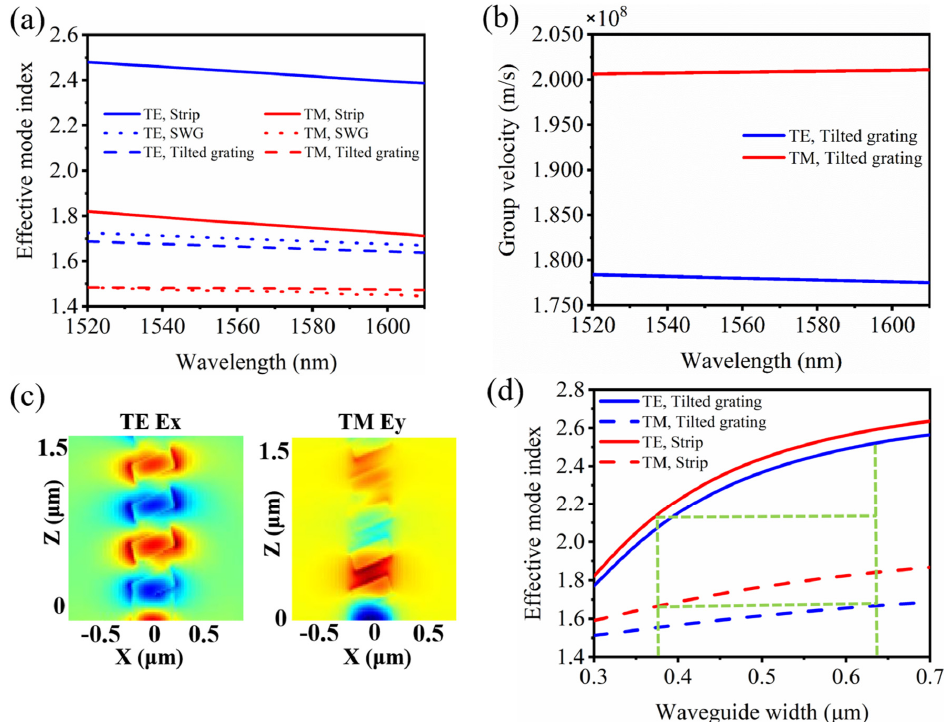
Figure 2. ( a ) Effective mode indices for TE and TM modes of the strip, SWG, and tilted grating waveg- uides. ( b ) Group velocities of TE and TM modes for tilted grating waveguide. ( c ) Corresponding electric fields for the TE (Ex) and TM (Ey) modes propagating along the tilted gratings. ( d ) Effective mode indices of TE and TM modes for different strip and tilted grating waveguide